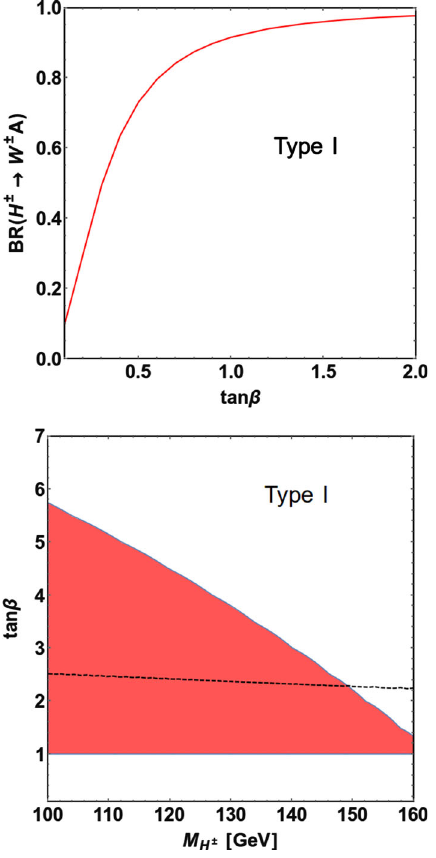
Fig. 6 Branching fraction of H ± → W ± A as a function of tan β (upper plot) for M H ± − M A = 85 GeV and M H ± = 150 GeV. The exclusion region (bottom plot) in Type I is shown in red color from the first upper limits on BR ( t → H + b ) CMS 13 TeV observations in the charged Higgs decay mode: H ± → W ± A and A → μ + μ − with the assumptions BR ( H ± → W ± A ) = 1 and BR ( A → μ + μ − ) = 3 × 10 − 4 . For the charged Higgs bosonic decay channel the mass difference M H ± − M A = 85 GeV for M H ± ∈ [ 100 , 160 ] GeV is considered. The region below the black dashed line is excluded by BR( B → X s γ )